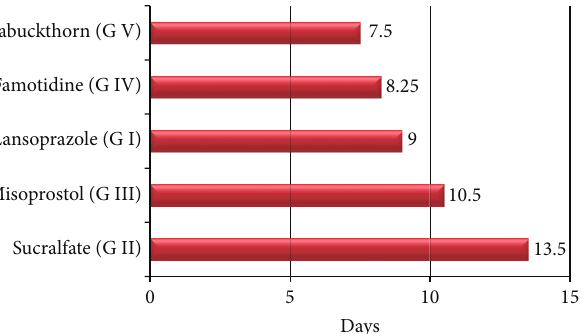
Figure 2: Average number of days to achieve 0 GUE index in different